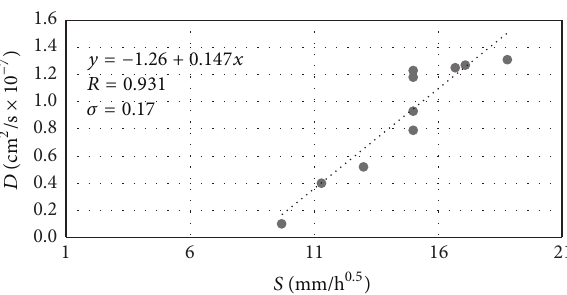
Figure 11: Chloride diffusion versus % 𝑅 .